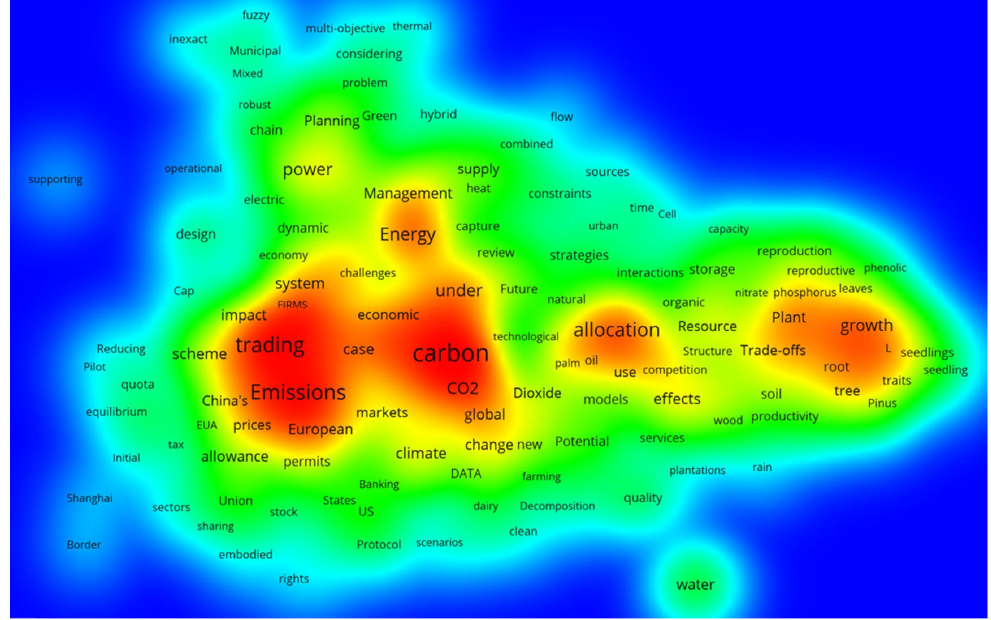
Figure 6. Thermal map of title word density.